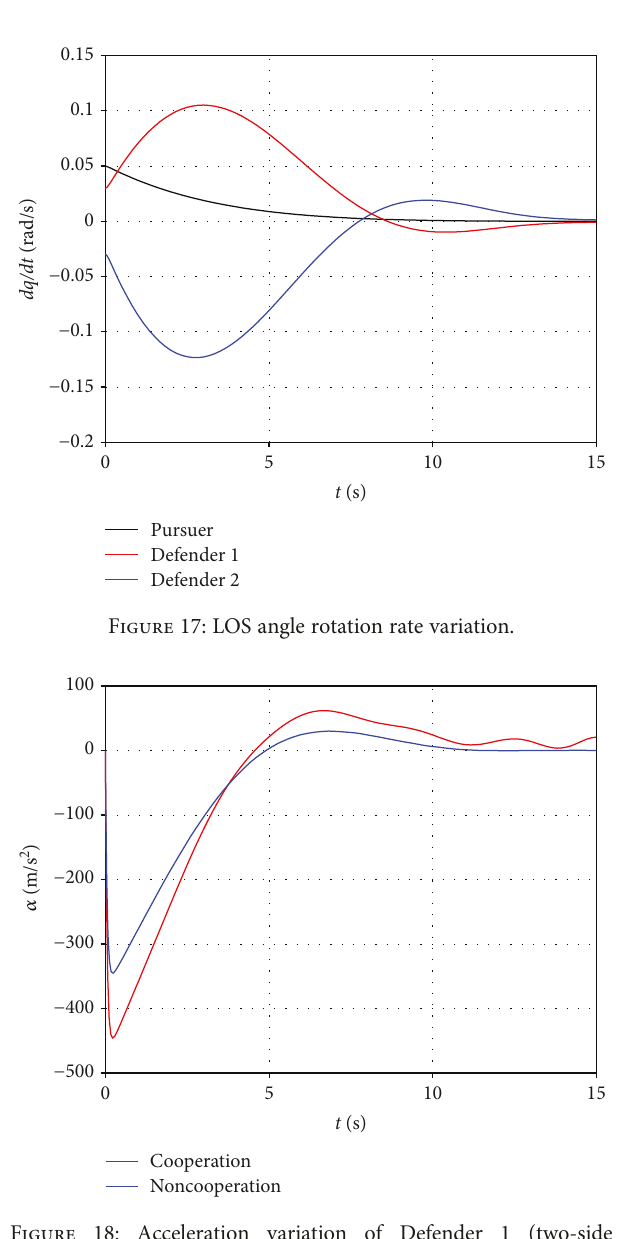
Figure 18: Acceleration variation of Defender 1 (two-side intercept).